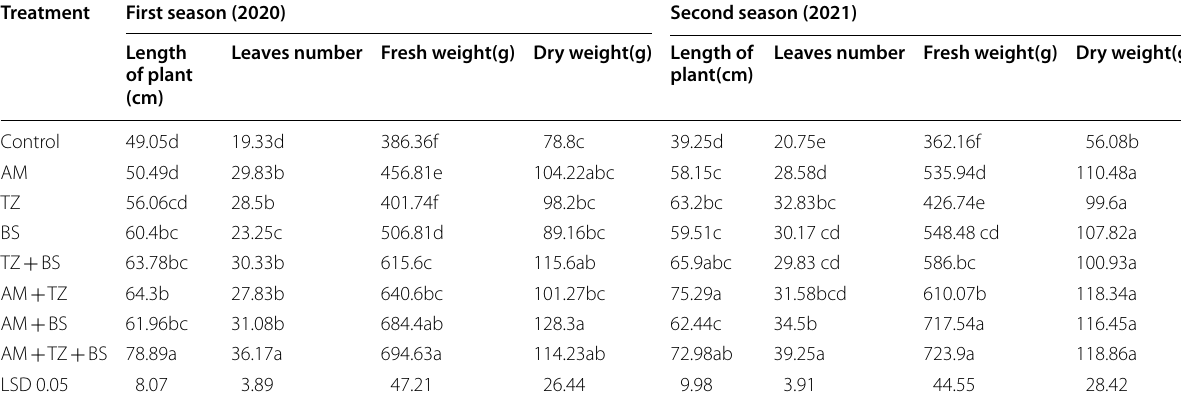
Means in a column followed by the same letters are not significantly different (LSD, P < 0.05). Arbuscular Mycorrhizal fungi (AMF), Trichoderma harzianum ( TZ ) , Bacillus subtills (BS), control (without treatment)